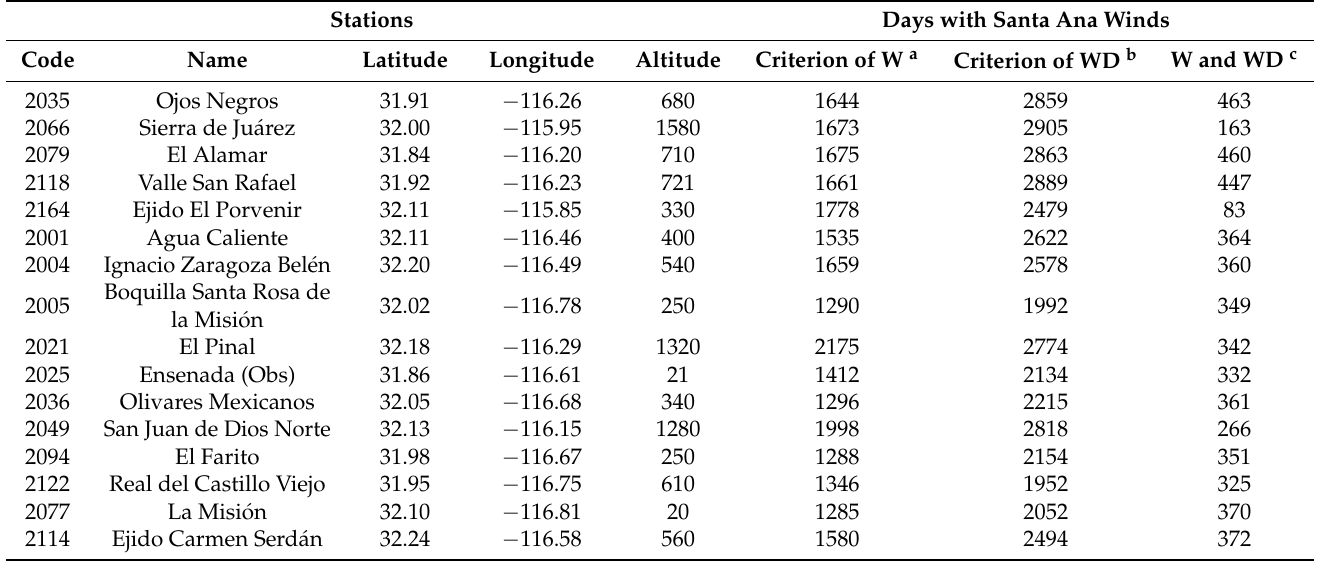
Table 2. Criteria for selecting days with Santa Ana winds.